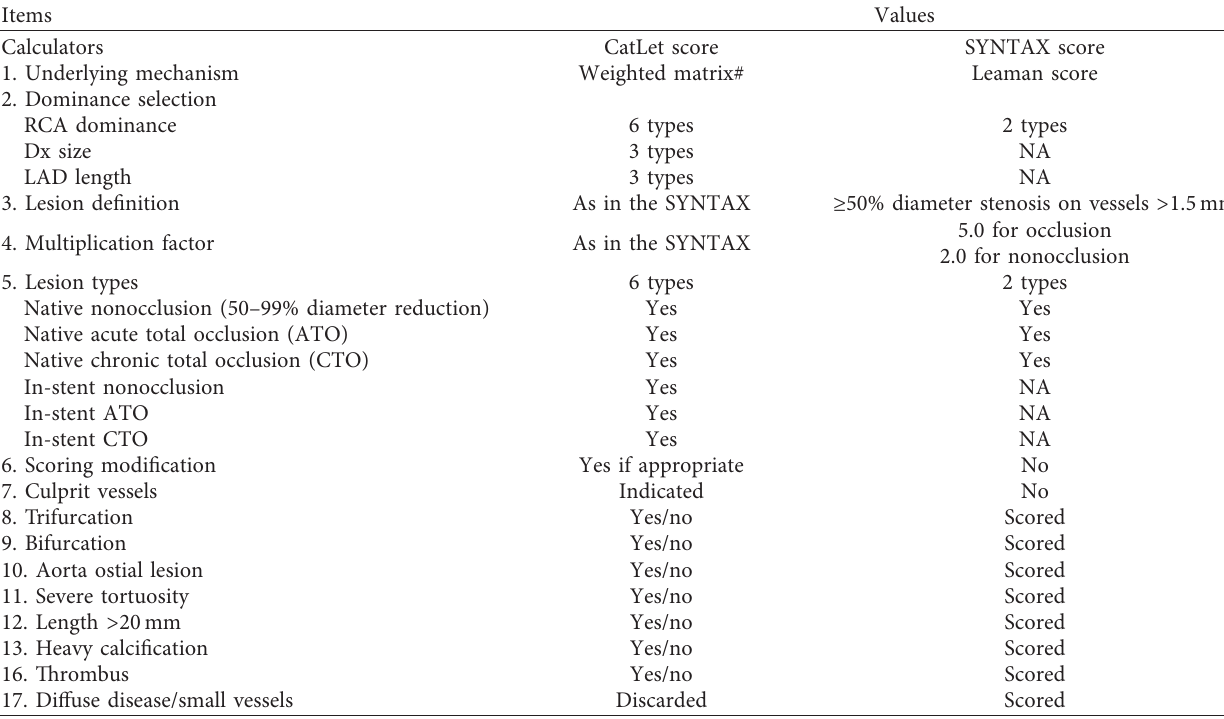
Table 2: Differences and similarities with respect to criteria and definitions between the SYNTAX score and CatLet score. Items